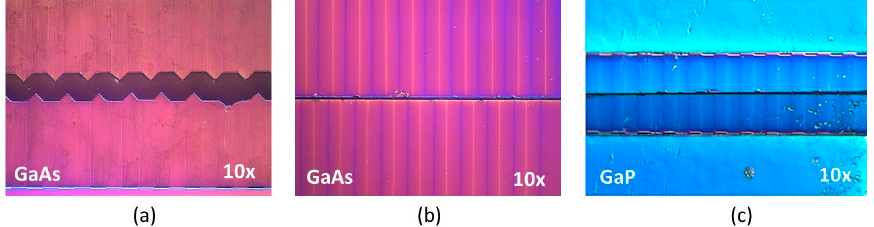
Figure 32. Two pieces of grown OPGaAs: ( a ) before, and ( b ) after polishing off the triangular parts on the domain top surfaces; ( c ) two already faced against each other and aligned OPGaP pieces ready for high temperature bonding.